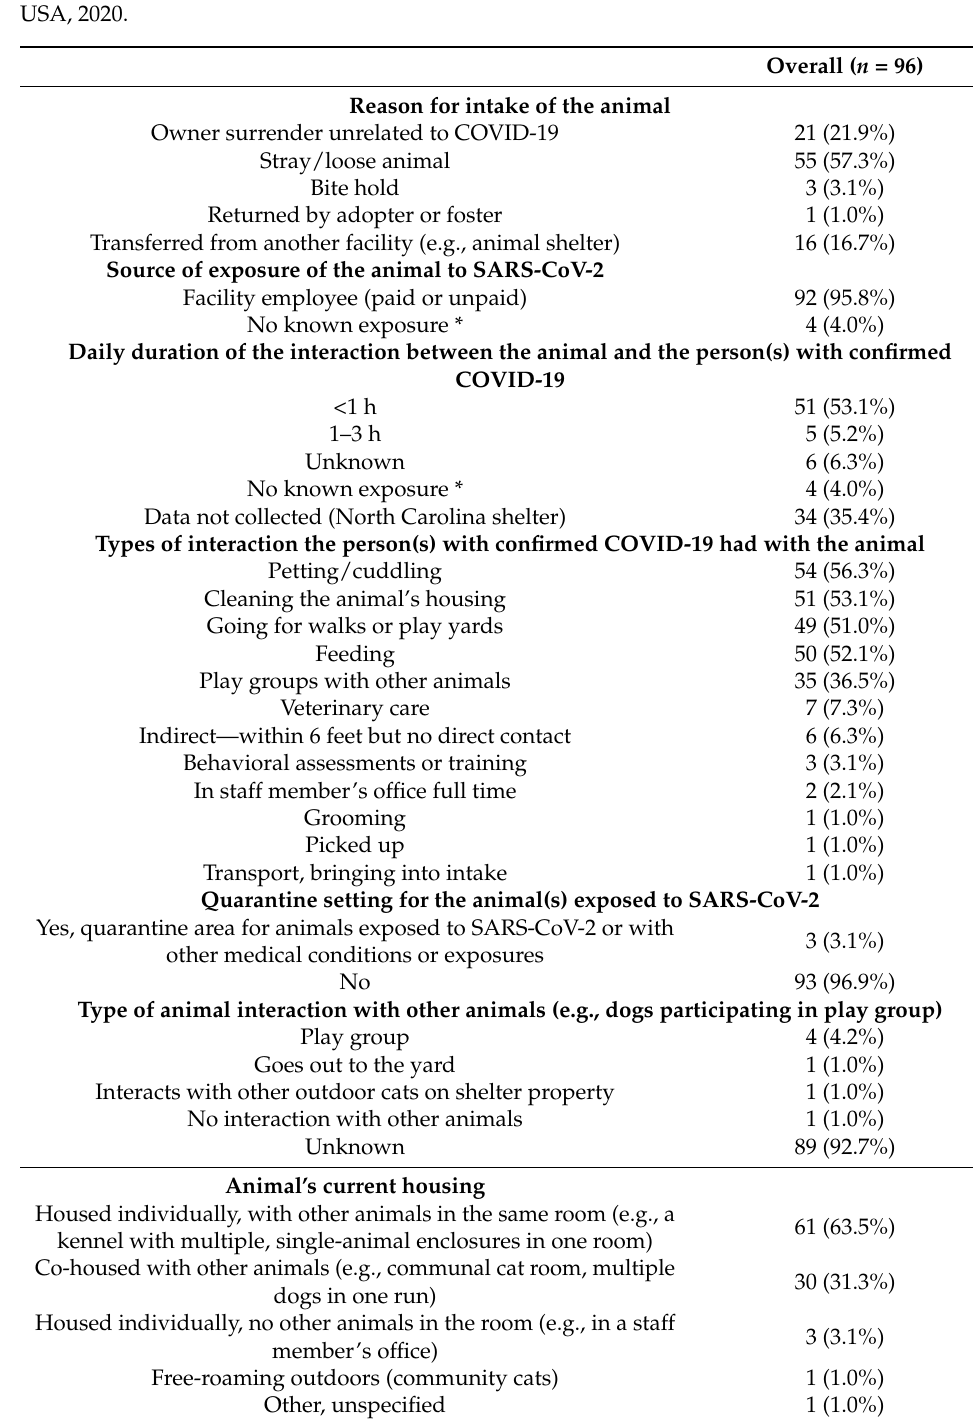
Table 2. Characteristics of intake, history of SARS-CoV-2 human-to-animal exposure(s) and animal housing during an investigation of SARS-CoV-2 transmission in congregate animal settings